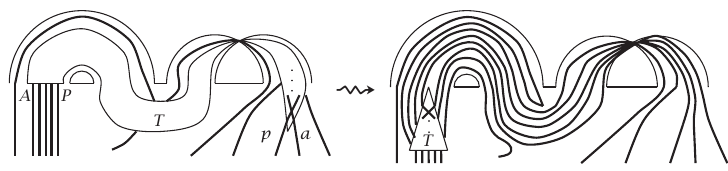
Figure 5.3 . Moving the basepoint to the left in p Σ (K) ∩ I